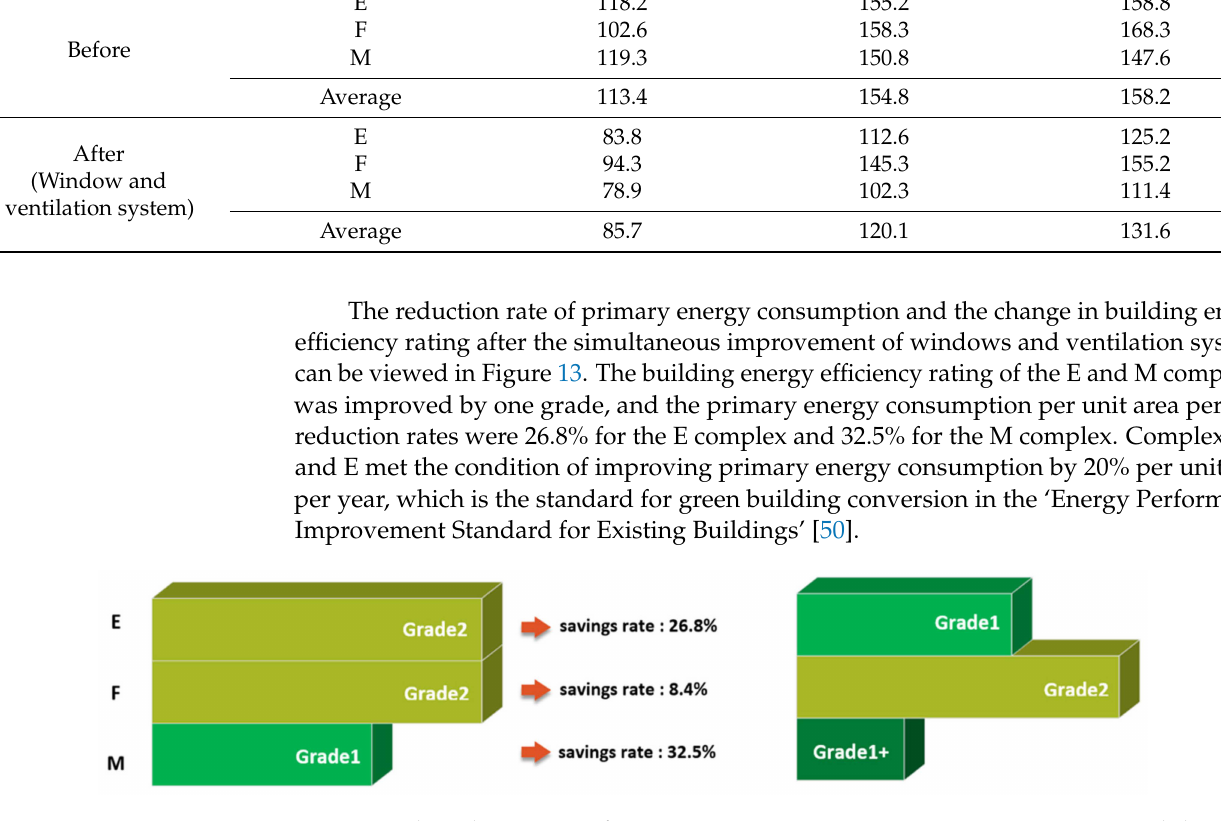
Figure 13. The reduction rate of primary energy consumption per unit area per year and changes in building energy efficiency ratings, due to improvements in windows and ventilation